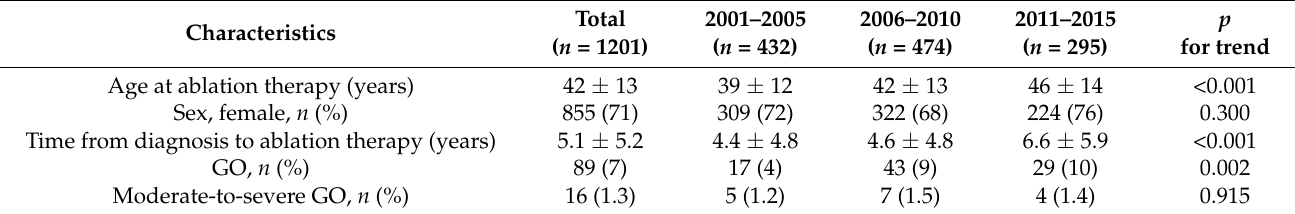
Table 1. Comparison of clinical characteristics for patients who underwent ablation therapy according to the period. Characteristics